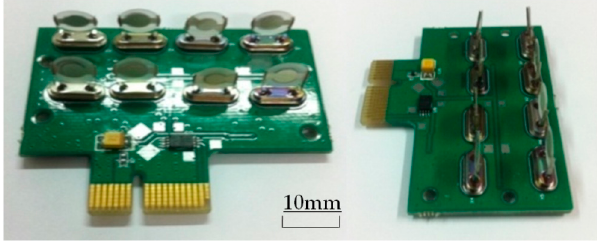
Figure 3. Image of the novel polymer quartz piezoelectric crystal sensor array. Table2. List of the eight polymer components employed in the 8-channel sensor array.